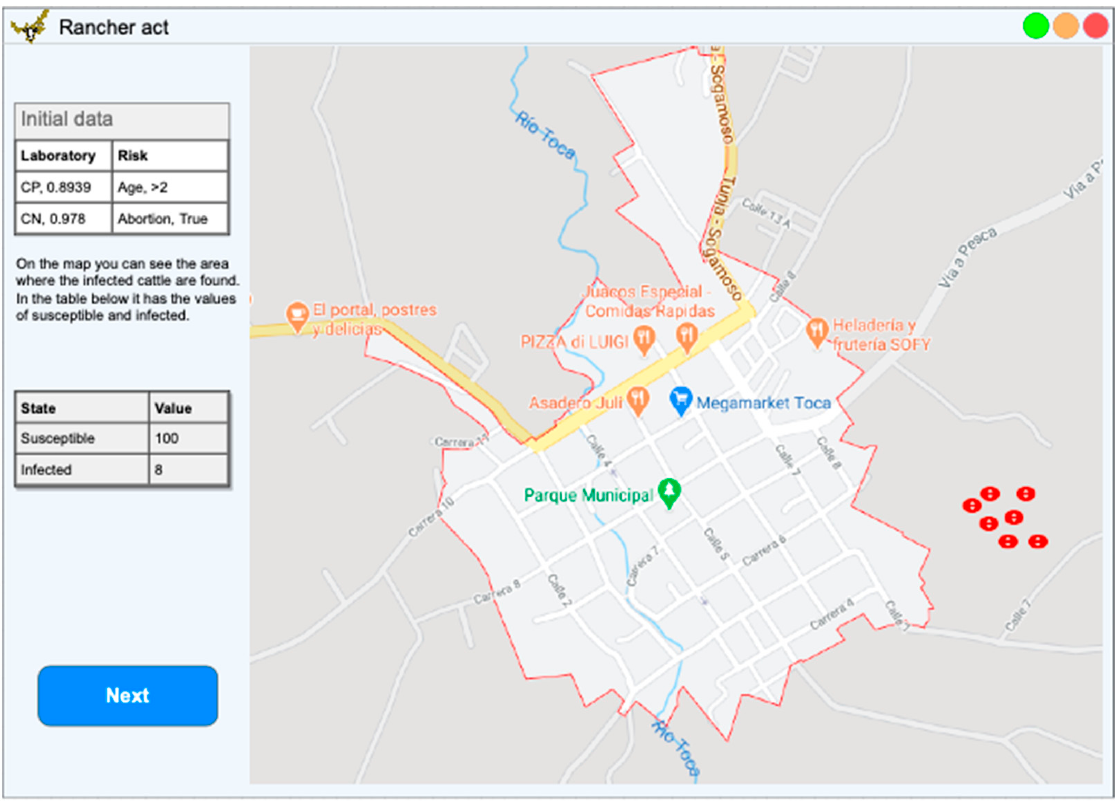
Figure 5. Presentation of the information to the livestock user.